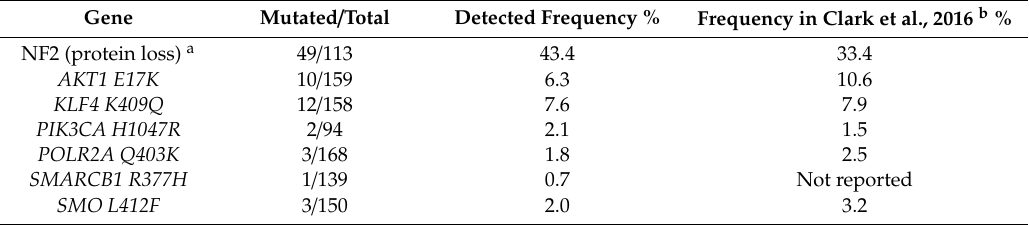
Table 1. Mutational frequencies detected by endpoint